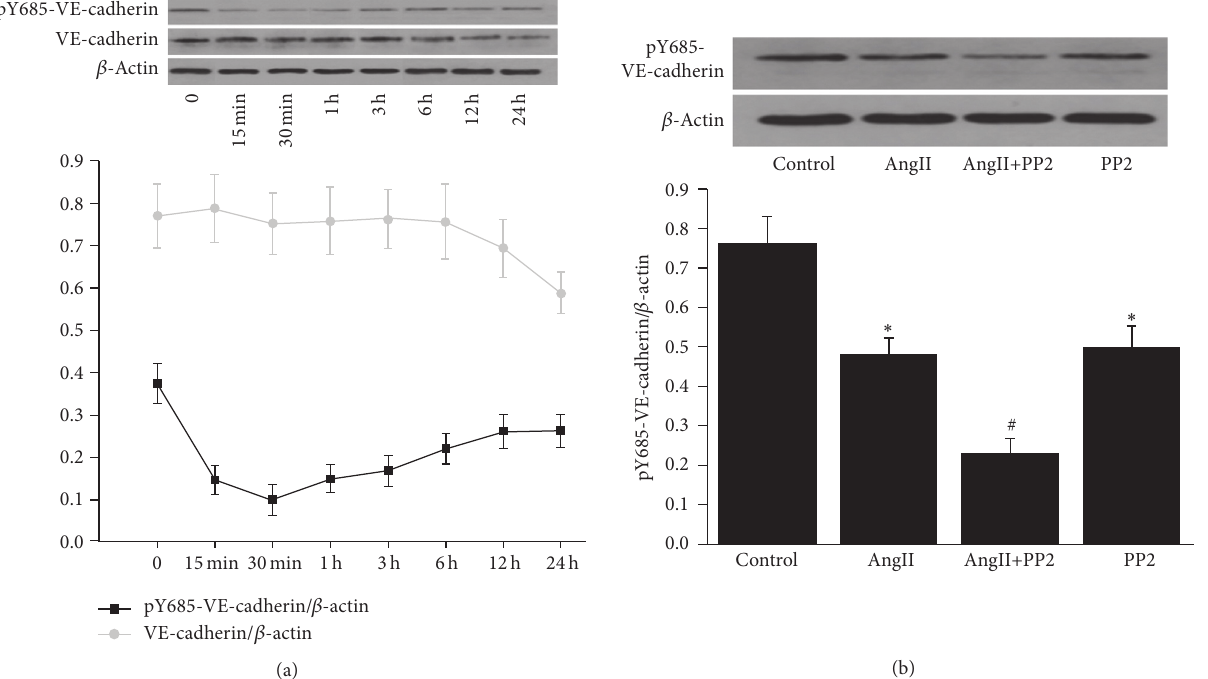
Figure 6: Expression of total pY685-VE-cadherin protein and VE-cadherin in cultured PMVECs. (a) The phosphorylation of Y685 of VE- cadherin induced by AngII in PMVECs was in a time-dependent manner. About 30 minutes after AngII stimulation, the dephosphorylation of Y685-VE-cadherin reached the peak level, whereas, 12 h after AngII stimulation, the VE-cadherin was decreased in PMVECs. (b) AngII or PP2 resulted in reduction of pY685-VE-cadherin in PMVECs, while the pY685-VE-cadherin was further decreased in the AngII+PP2 group. ∗ 𝑃 < 0.05 versus control group; # 𝑃 < 0.05 versus AngII